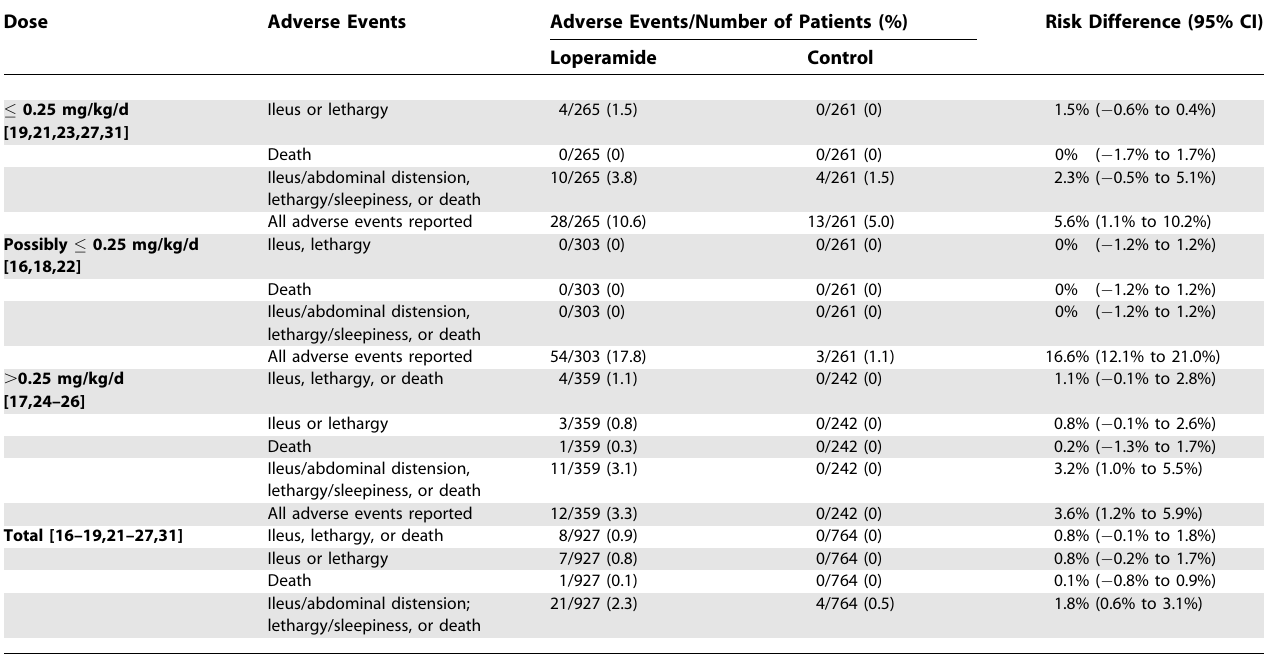
Table 3. Adverse Events: Prevalence of Adverse Events in Patients Treated with Loperamide or Placebo Dose Adverse Events Adverse Events/Number of Patients (%) Risk Difference (95% CI) Loperamide Control